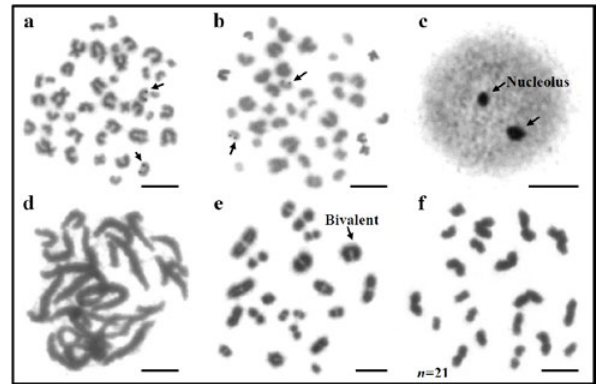
Fig. 5. Silver stained somatic metaphase complement of male (a) and female (b) of Cyrtodactylus interdigitalis , arrows indicate nucle- olar organizer region (NOR), and meiotic cell division of the male C. interdigitalis on interphase by silver NOR staining (c), pachytene (d), metaphase I (e), and metaphase II (f) (scale bars = 10